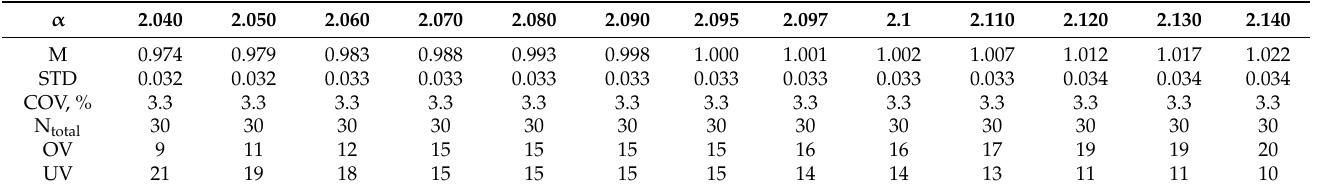
Table A8. The influence of α on the statistical results of L t.teor /L t.exp of AFRP Fibra and Technora bars.